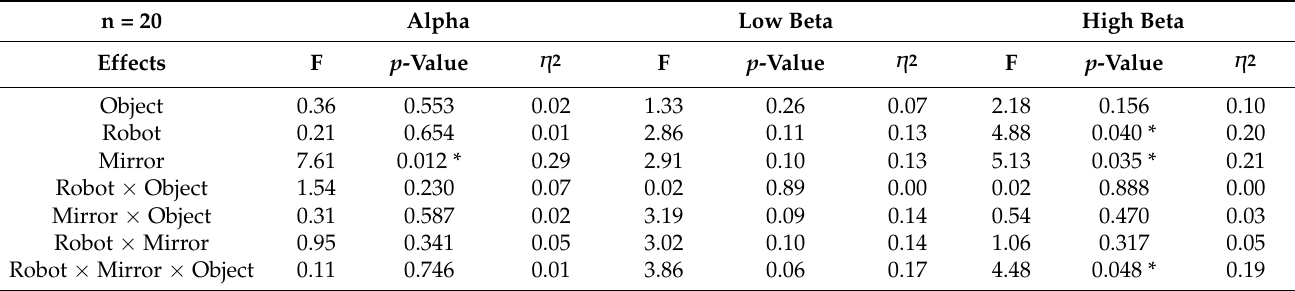
Figure 4. Interhemispheric coherences in the three bands: the alpha, low beta, and high beta bands. As the two groups had significant differences in stroke onset times, they were sepa- rately analyzed in the following analyses. In each analysis of the onset ≤1 year group and onset >1 year group, we first examined the interaction effect of the damaged brain area (cortical vs. subcortical) and affected hand side (right hemisphere vs. left-hemispheric), respectively. If the interaction effect was significant, an additional subgroup was used for further analysis.